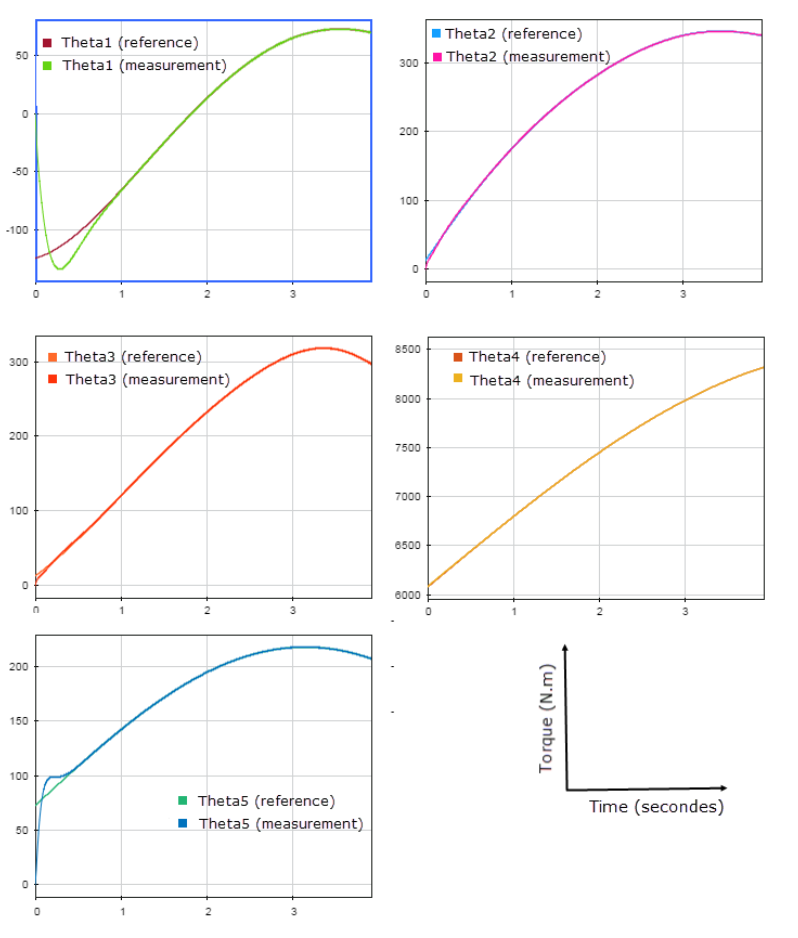
Figure 33. Comparison between the references and the measurements of the